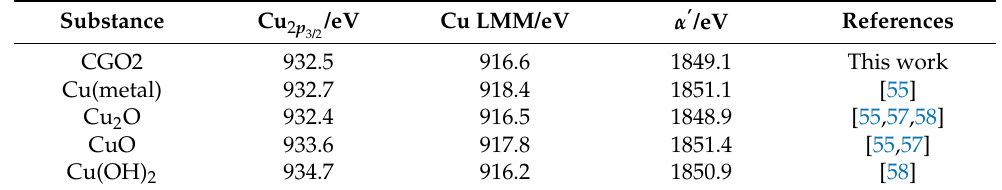
Table 4. Binding energies for the Cu 2 p XPS CL peaks and kinetic energies for the Cu L 3 M 4.5 M 4.5 3/2 Auger peaks, and the modified Auger parameters α (cid:48) for CGO2 and various copper compounds in eV ( ± 0.1 eV).